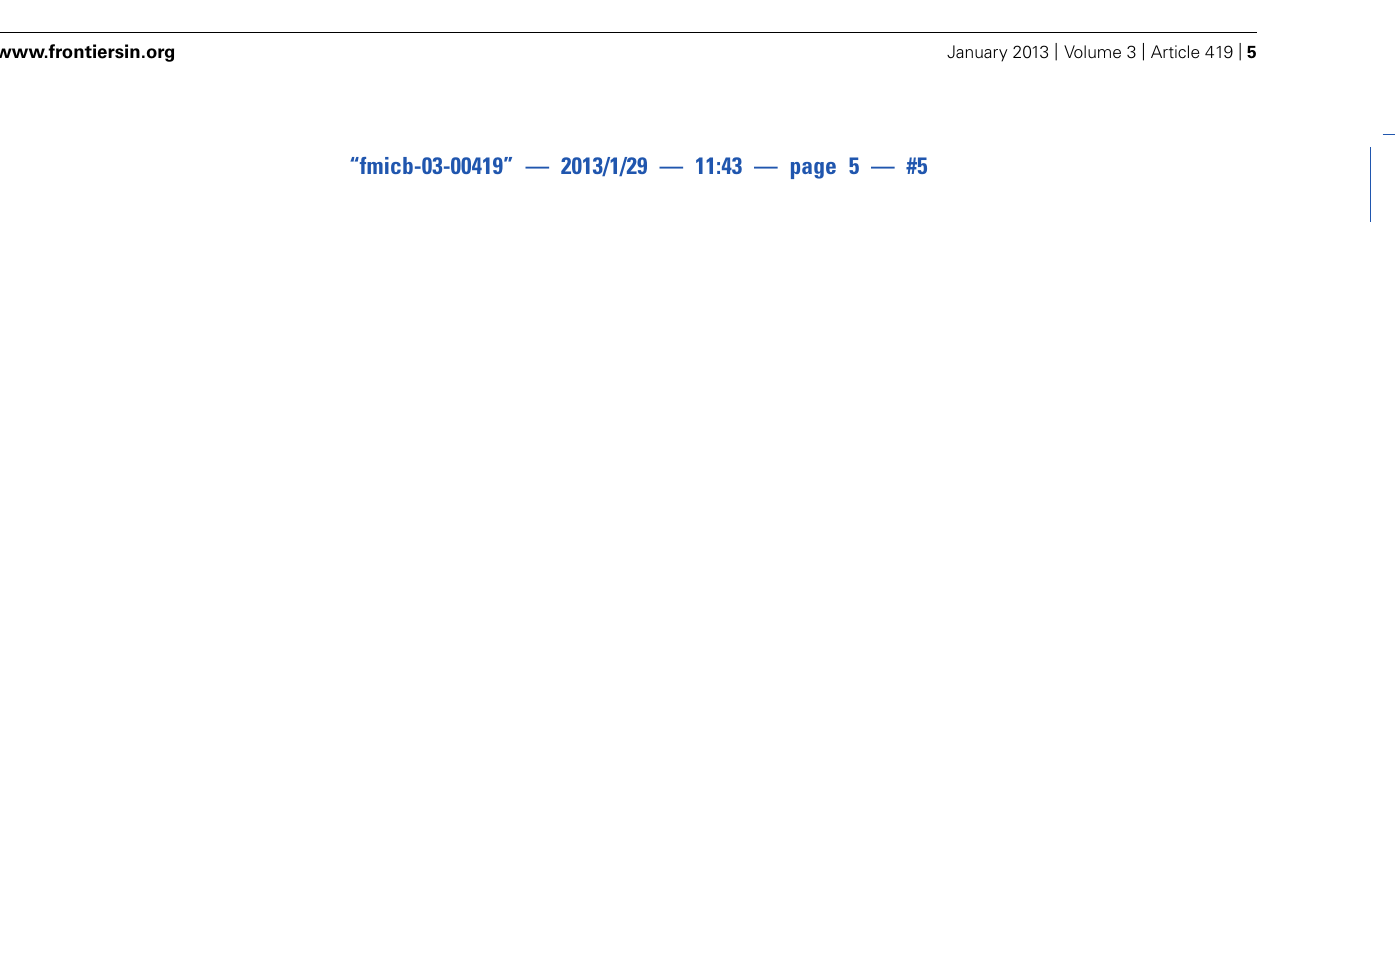
ACTIVE SITE STRUCTURAL